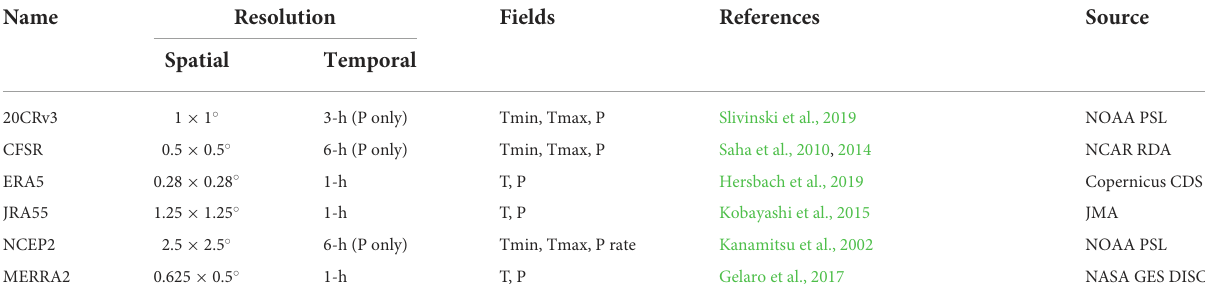
TABLE 2 Details of the reanalyses used in this